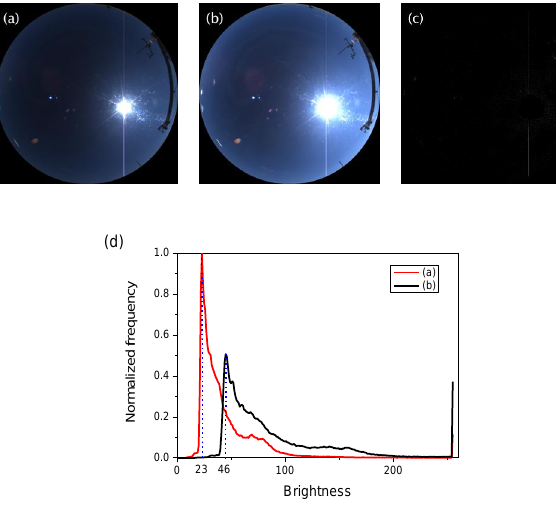
Figure 1. Relationships between the exposure time and the bright- ness value for the TCI images. (a) TCI image at exposure time of 300µs, (b) TCI image with the same lighting conditions and camera parameters as in (a) , but with 600µs exposure time, (c) difference of 2 × (a) and (b) for the green channel, and (d) normalized brightness histograms distribution for the green channel of (a) and (b) .